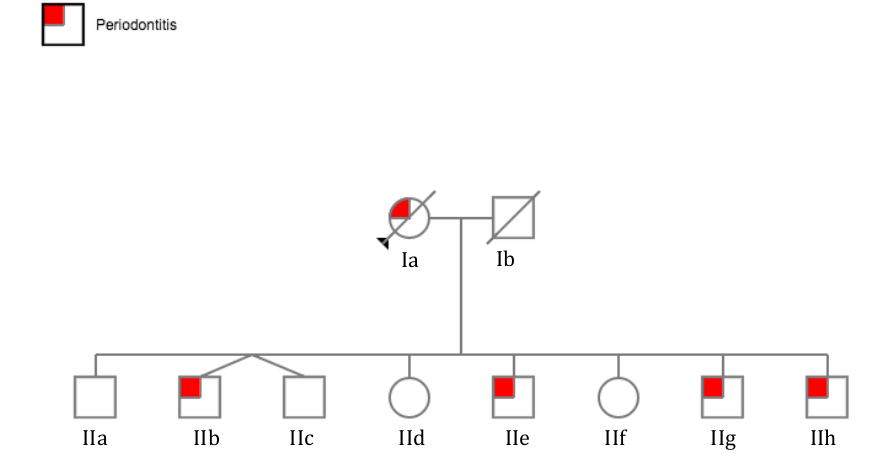
Figure 1. Pedigree of chronic periodontitis prevalence over two generations. Affected ind i-­‐ viduals marked in red. IIb and IIc represent identical twins; IIb is affected with periodont i-­‐ tis and IIc is